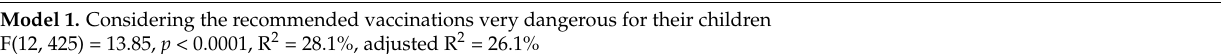
Table 2. Multivariate linear and logistic regression analyses indicating associations between several variables and the outcomes of interest. Variable Coeff.